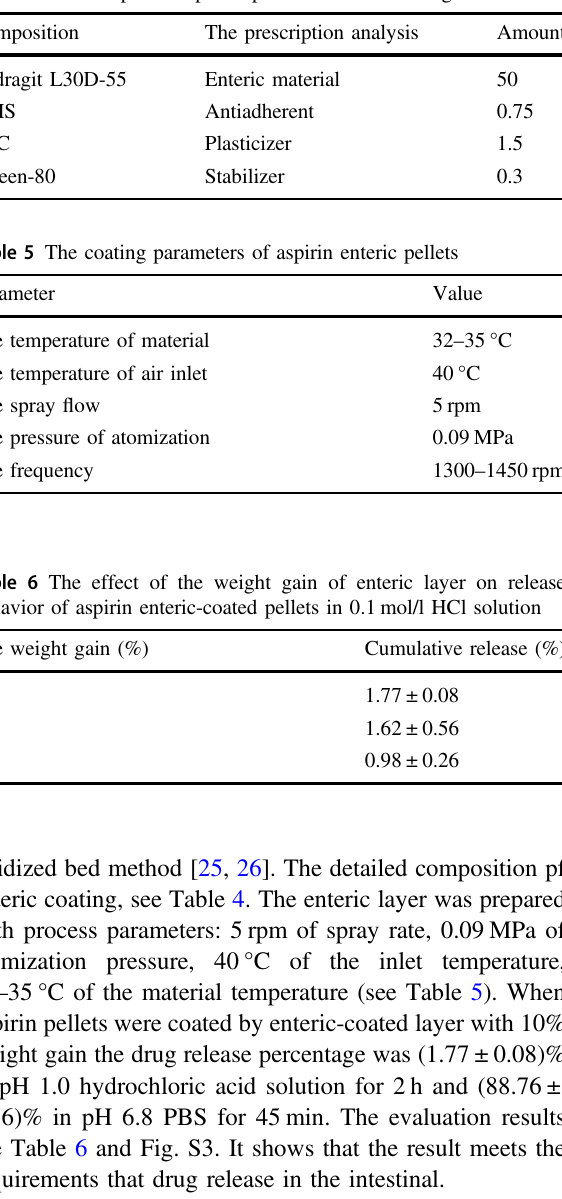
Table 4 The composition prescription of enteric coating solution